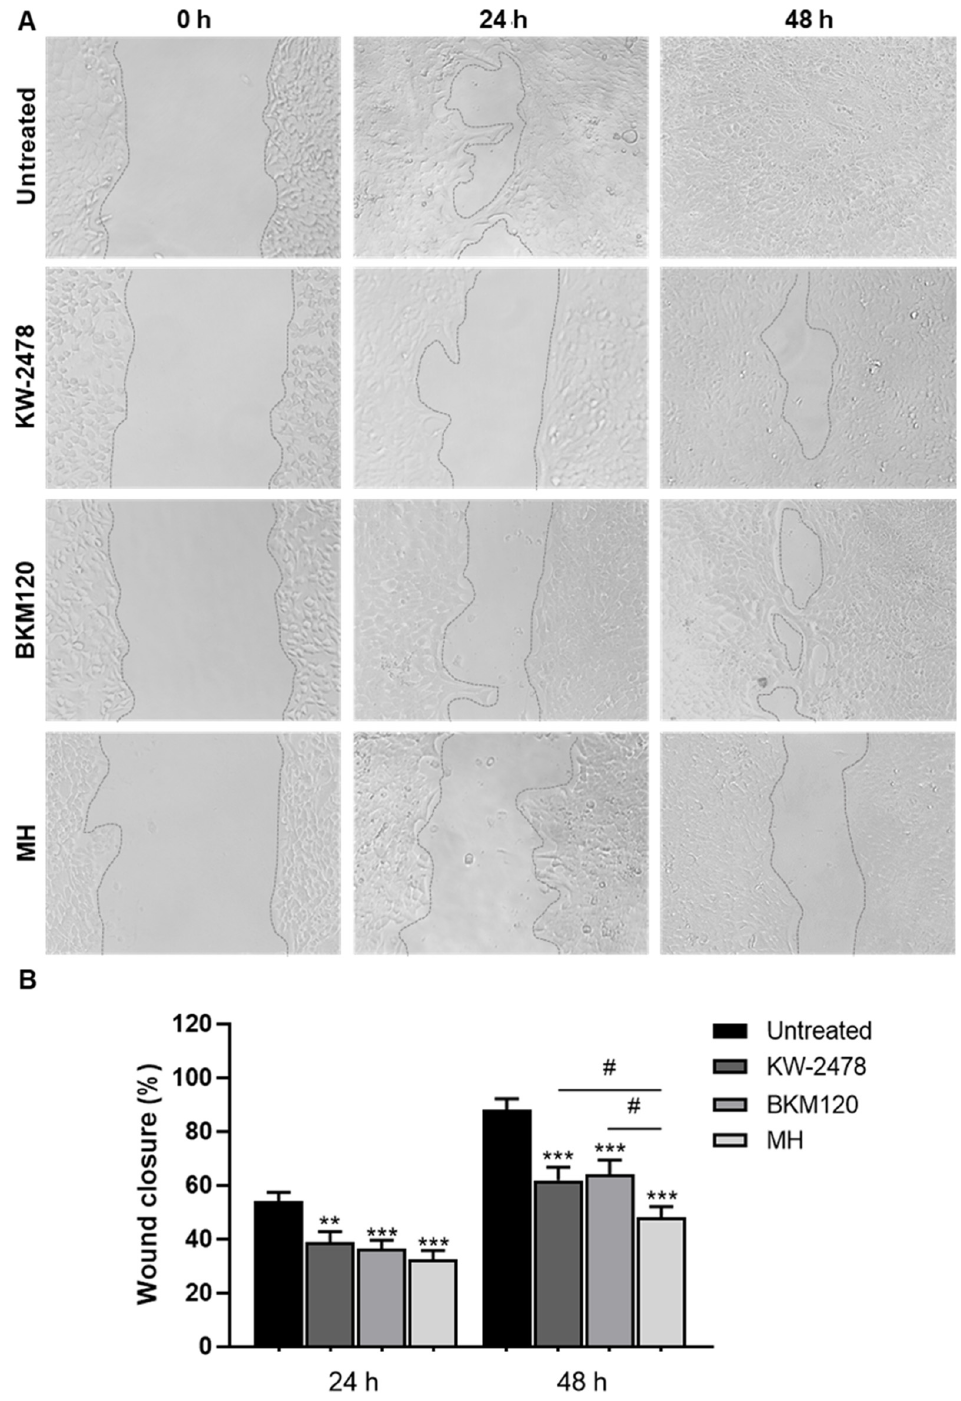
Figure 7. The 4T1 cell migration is inhibited by KW-2478 and BMK120 and especially by MH. The 4T1 cells were grown until confluence and then, after a scratch was made, incubated for 24 h or 48 h with BKM120 (0.1 µ M), KW-2478 (1 µ M), MH (1 µ M), or DMEM (untreated). ( A ) Wound closure was monitored over time and images were acquired with a phase contrast microscope at 0, 24, and 48 h, demonstrating that MH was the drug that better inhibited 4T1 migration. ( B ) Quantitative analysis of wound closure presented as percentage of untreated cells. Data represented as means ± SEM of three independent experiments, performed in triplicate. Statistical significances are denoted as ** p < 0.01 and *** p < 0.001 vs. untreated conditions within the same culture type and # p < 0.05 between the indicated conditions.